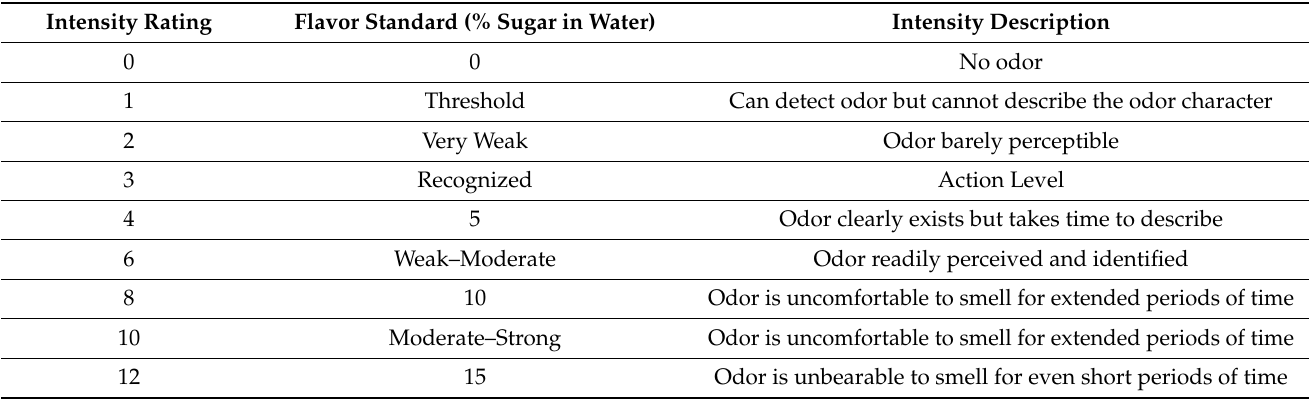
Table 1. Flavor Profile Analysis: Odor Intensity Strength Scale